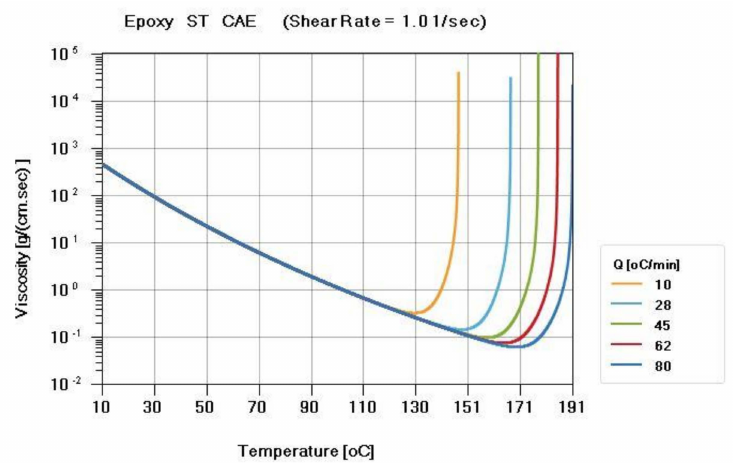
Figure 5. Viscosity curve of the ST resin. The viscosity is measured by a parallel-plate rheometer at different temperatures ramping rates (Q = 10, 28, 45, 62, 80 ◦ C/min) and the viscosity changes with